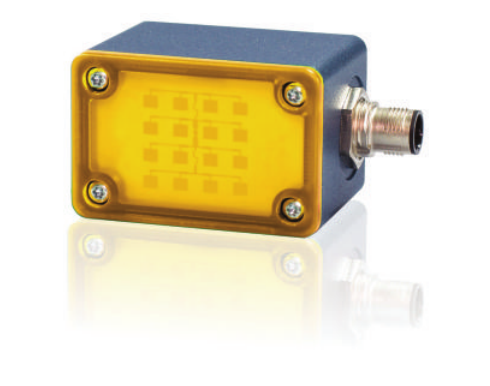
Figure 1: The developed Six-port radar